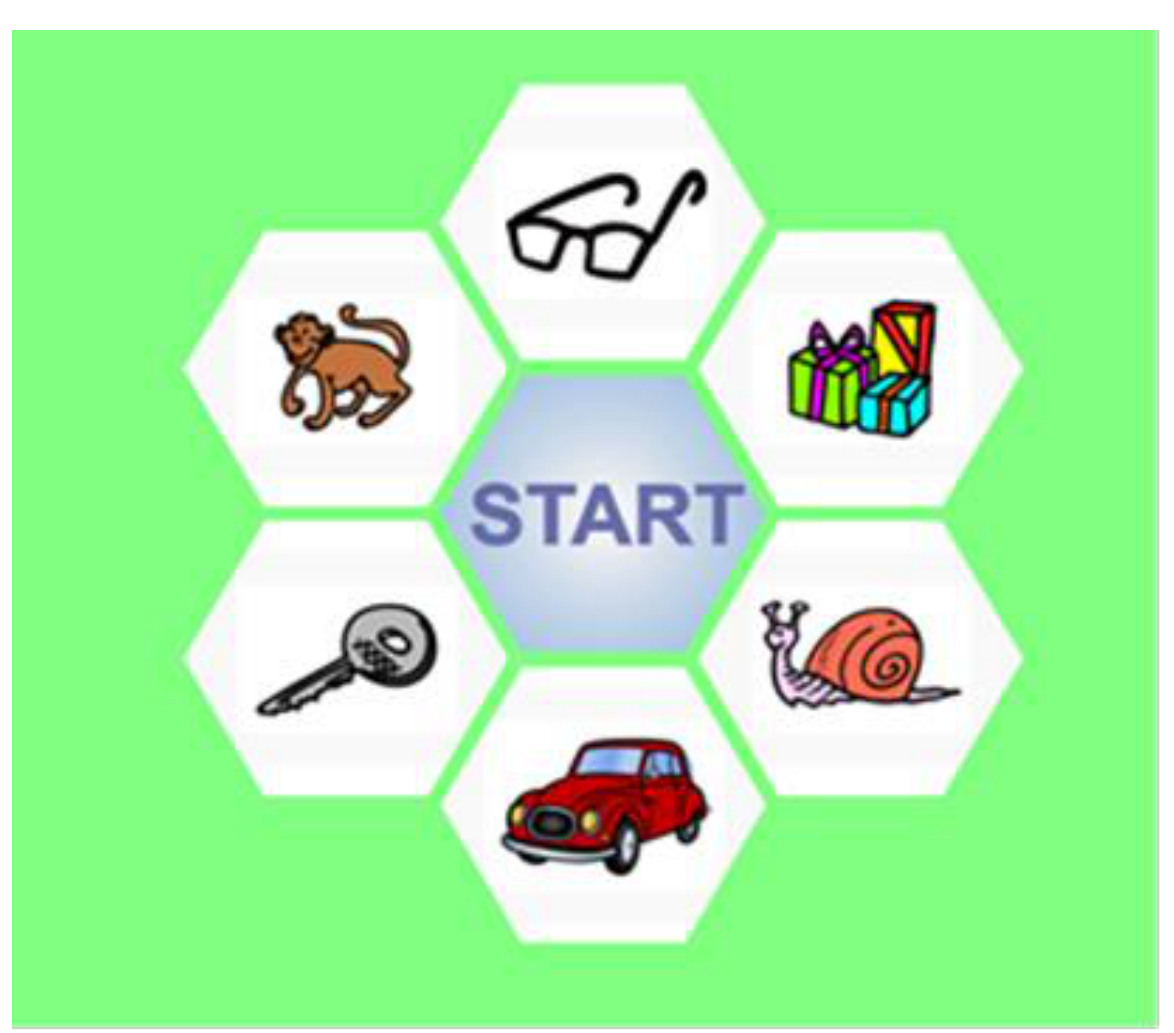
Figure 1. Interface of the pilot version of Maltese AAST.